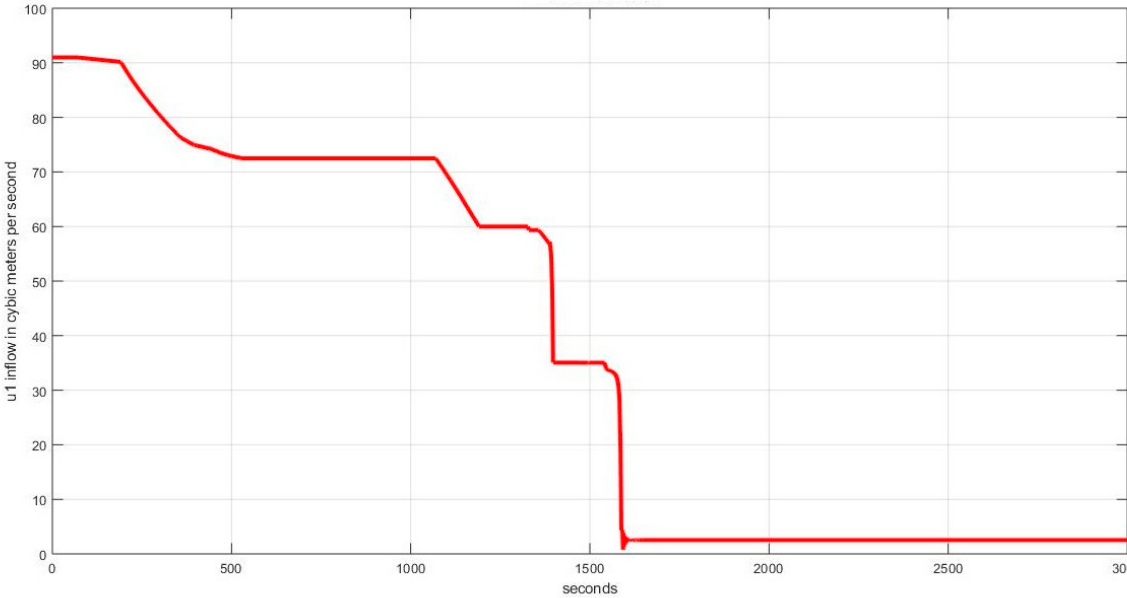
Figure 10. U1 control variable indicating the water inflow for the case in Figure 9.